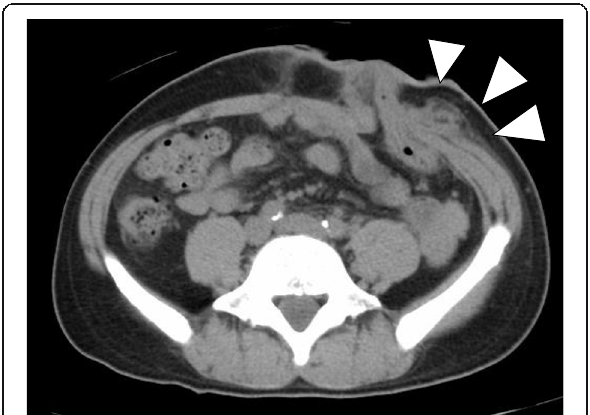
Fig. 2 Initial computed tomography of the abdomen revealed an abscess formation with air around the colostomy (white arrows)